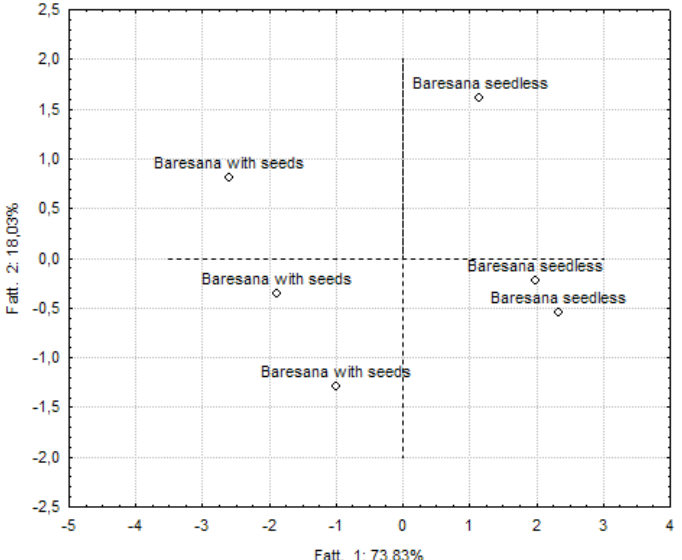
Figure 3. Principal component analysis applied to Baresana grape-based